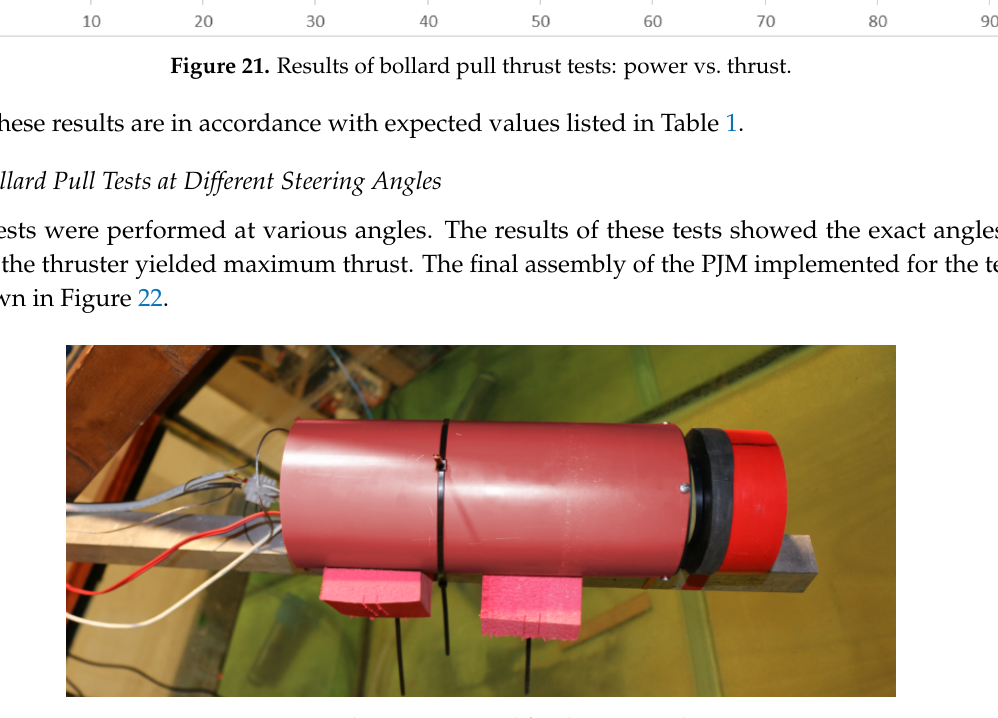
Figure 22. The PJM prepared for the testing